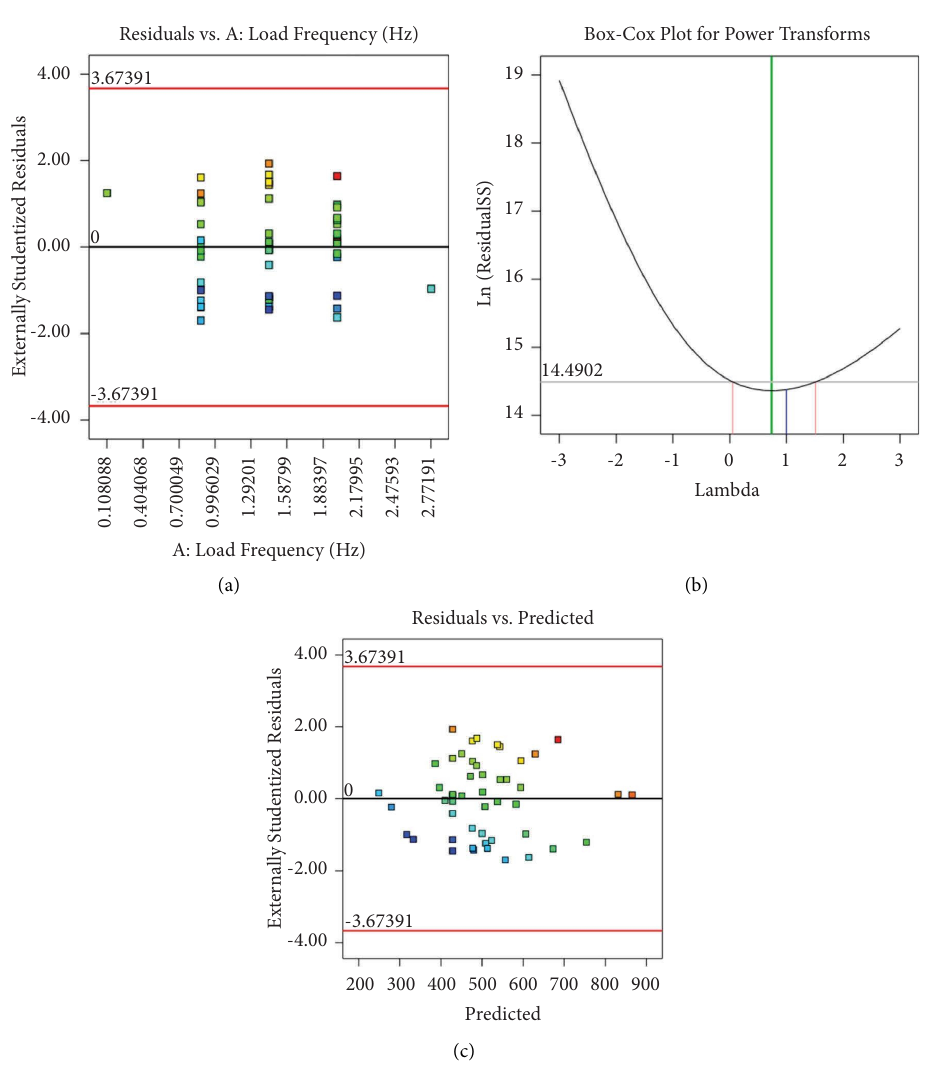
Figure 6: (a) Residuals vs. predicted values for damping constant. (b) Box–Cox plot for damping constant. (c) Residuals vs. process parameter for damping